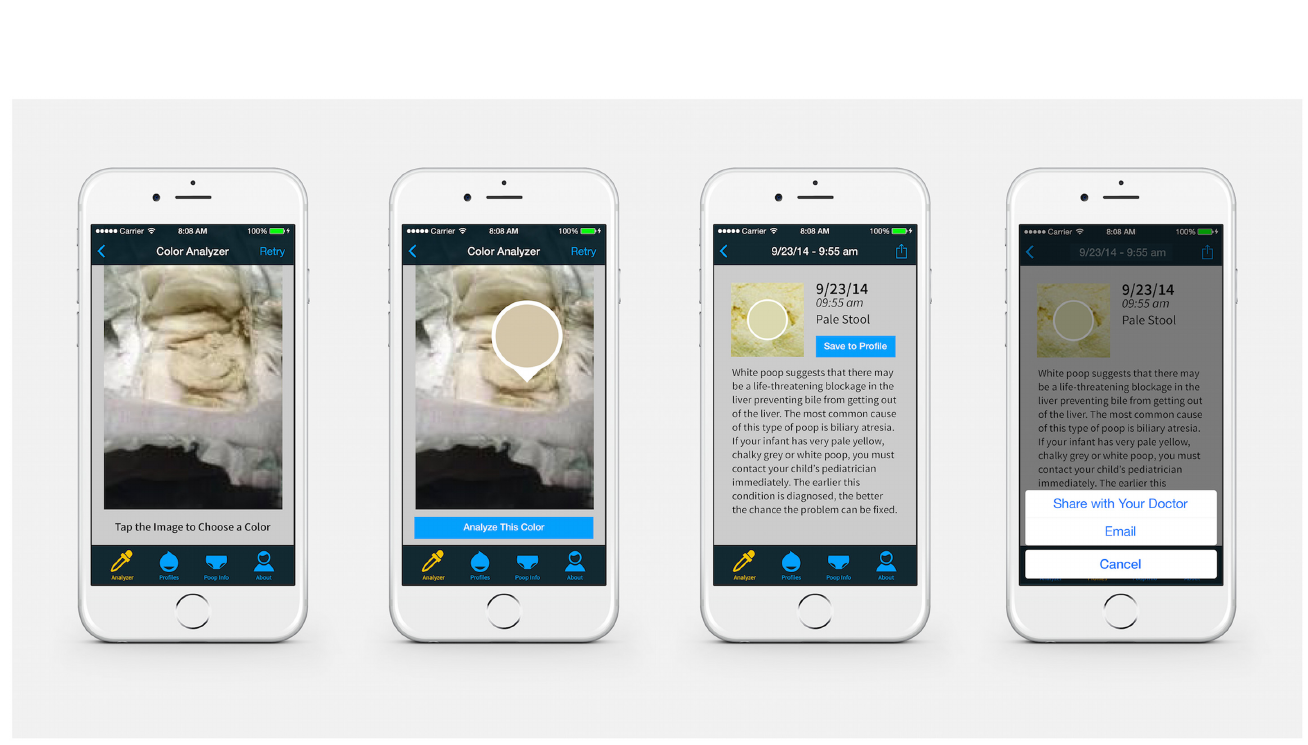
Fig 2. Screenshots demonstrating PoopMD analytic functionality.